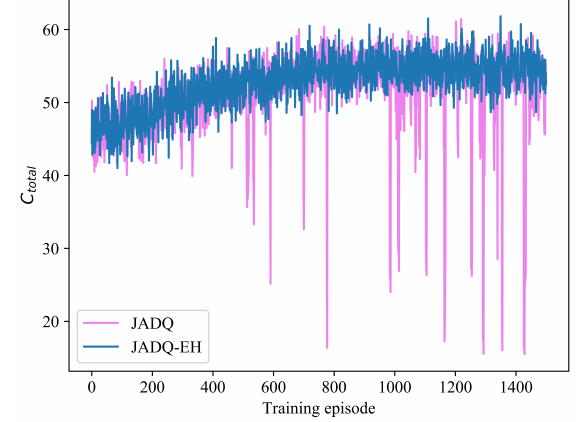
Figure 10. C total comparison of JADQ-EH and JADQ under scenario